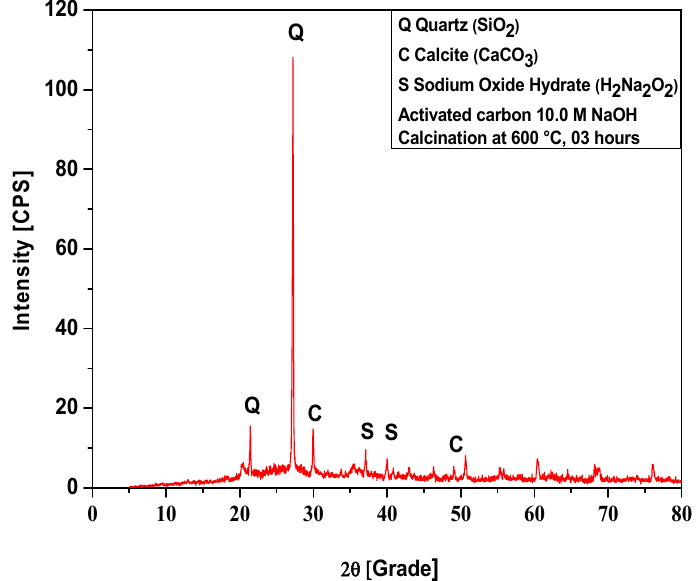
Figure 9. XRD of activated carbon pellets impregnated with 10.0 M NaOH after calcination at 600 600 ◦ C, 3 °C, 3 h.